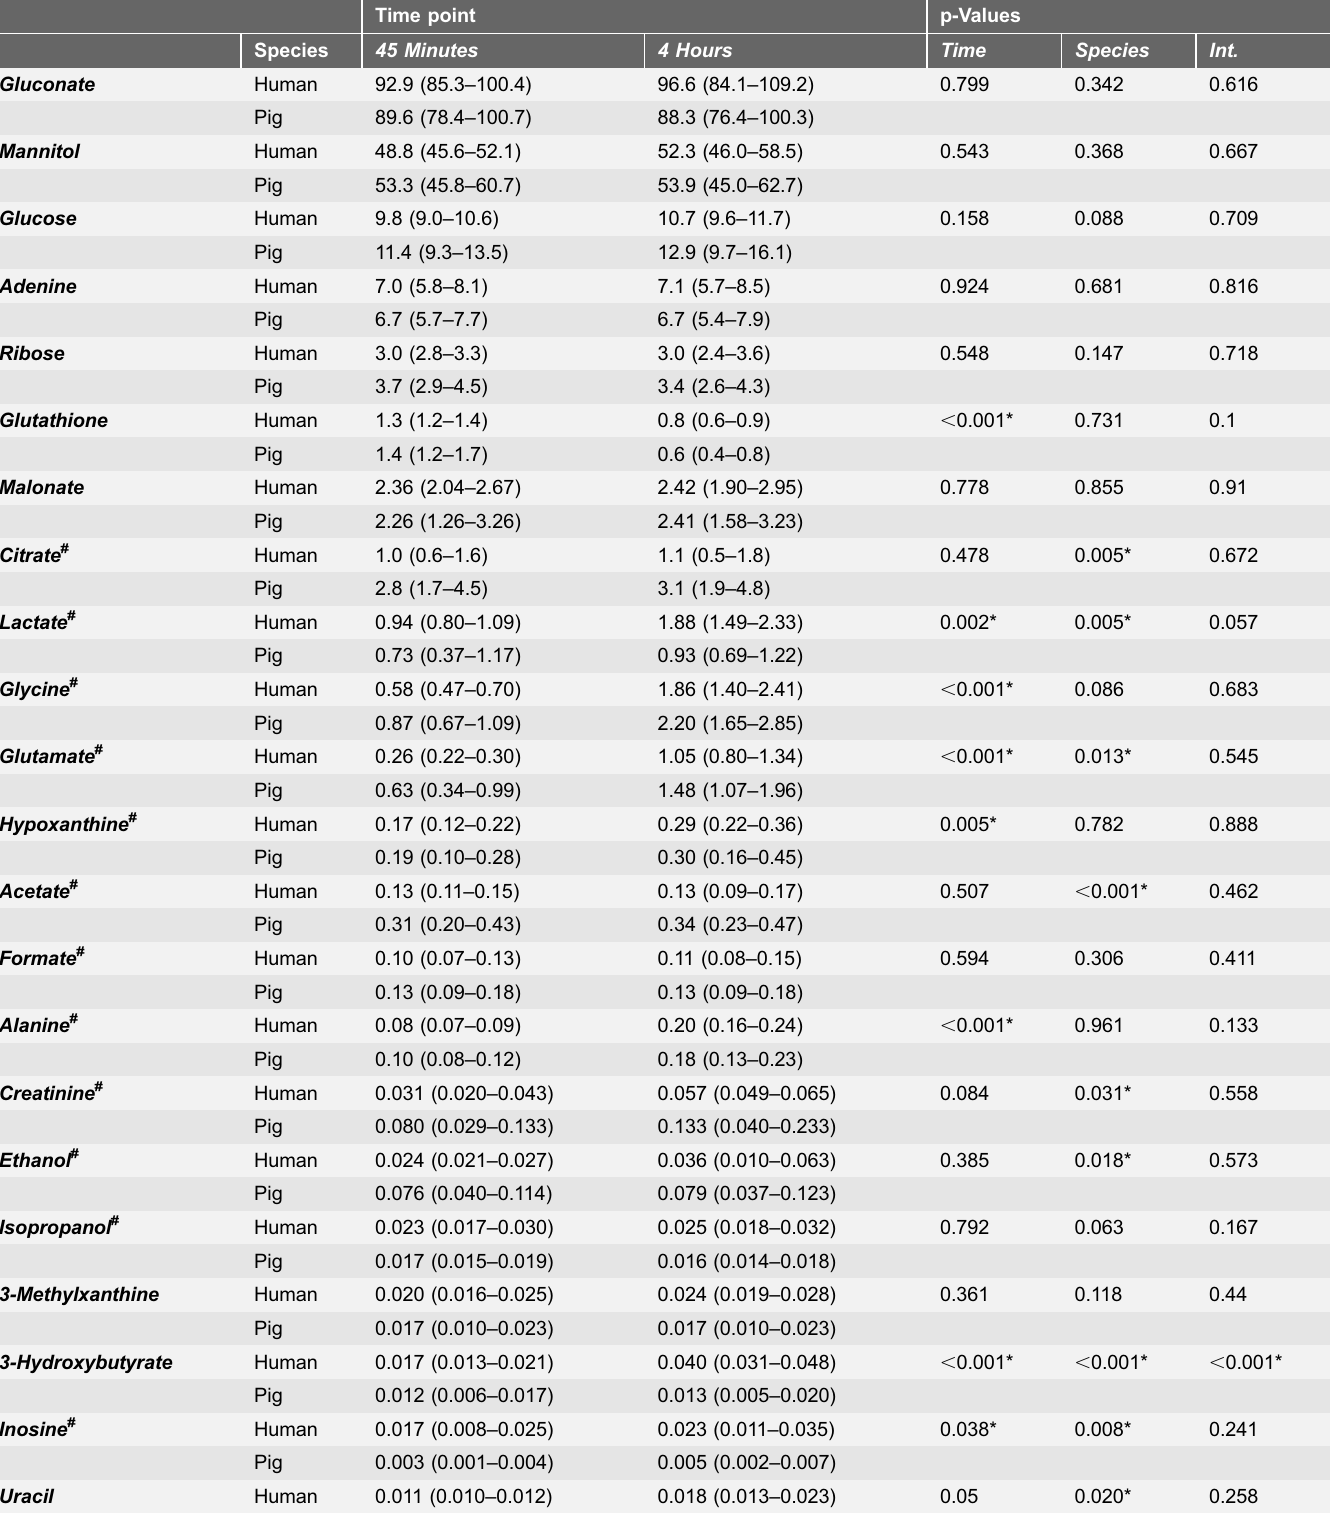
Table 1. Concentration of metabolites present after 45 minutes and 4 hours of perfusion in pig and human